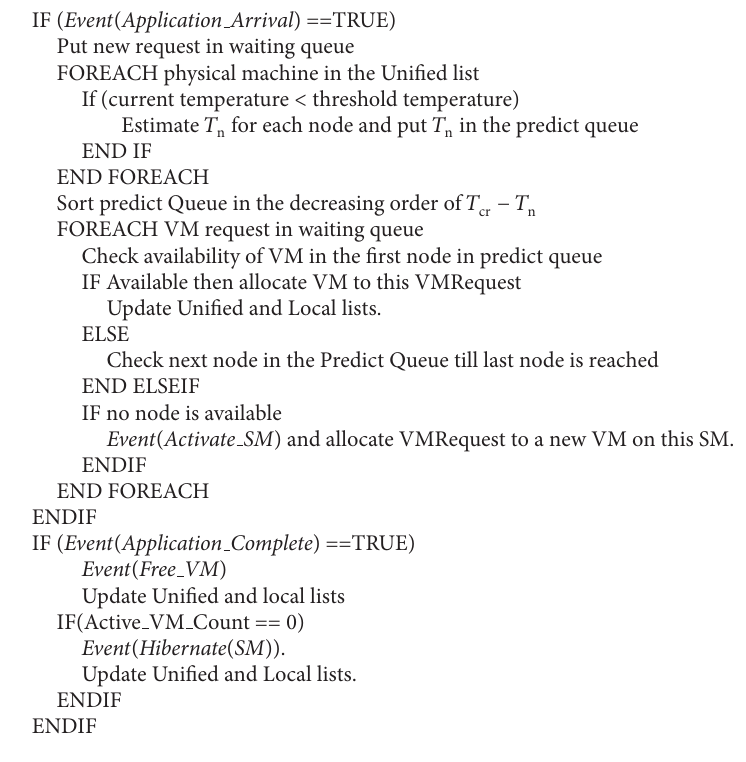
Algorithm 1: Proactive thermal VM scheduling.